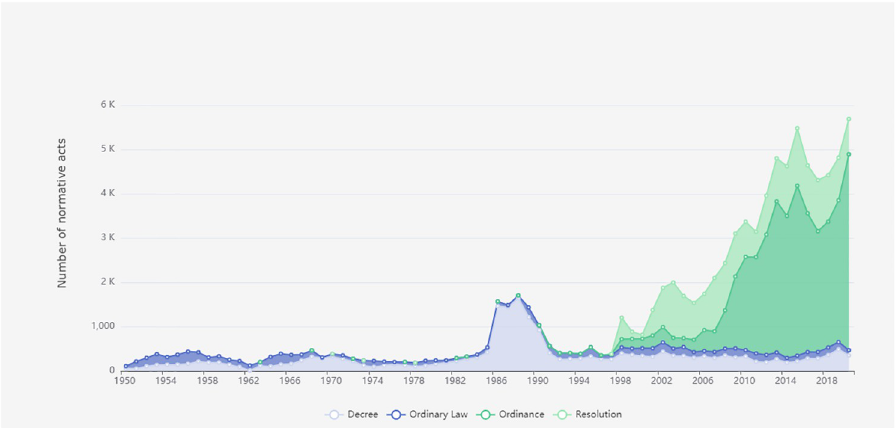
Fig 4. Regulatory stock evolution over